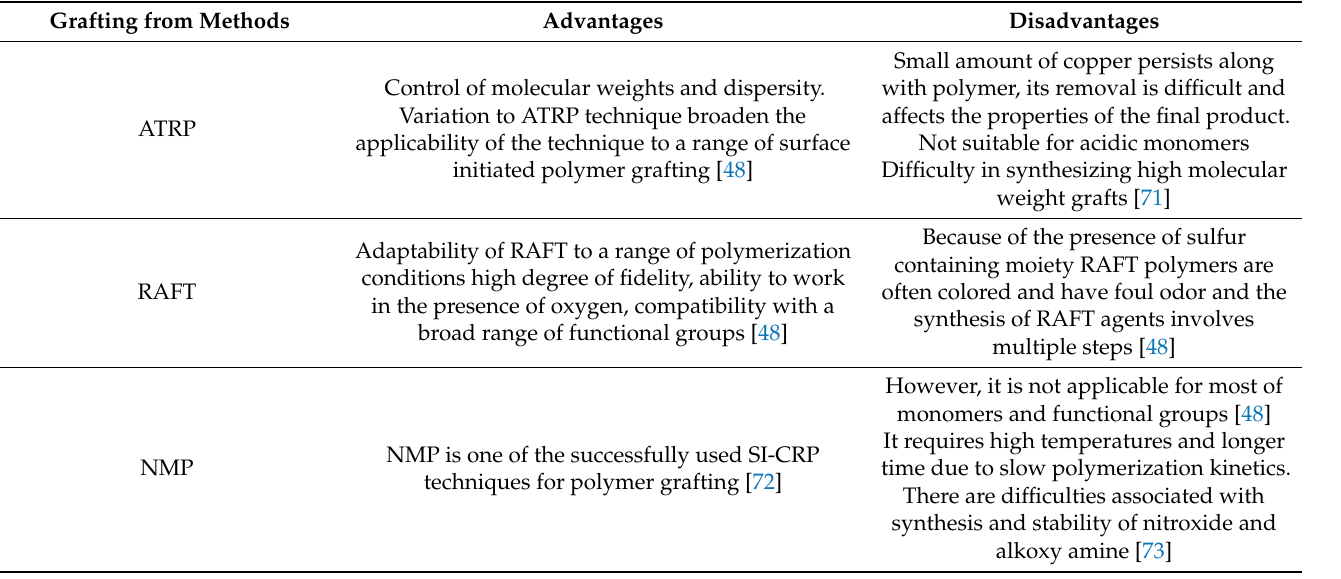
Table 2. Comparison of advantages and disadvantages of grafting from